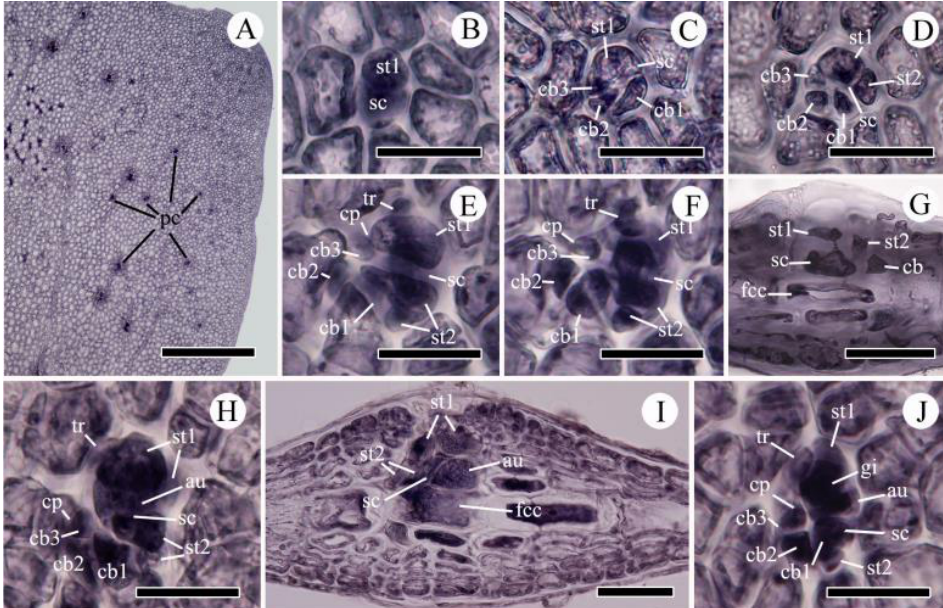
Figure 5. Female reproductive structures of Acrosorium flabellatum Yamada. ( A ) Positions of procarps (pc). ( B – G ) Procarp development. ( G ) Cross-sectioned mature procarp. ( H ) Surface view of early post-fertilization stage. ( I ) Cross-section view of early post-fertilization stage. ( J ) Surface view of young cystocarp before pericarp formation. au, auxiliary cell; cb, carpogonial branch (numbers, cell order); cp, carpogonium; fcc, fertile central cell; gi, gonimoblast initial; sc, supporting cell; st1, first sterile cell group; st2, second sterile cell group; tr, trichogyne. Scale bars: ( A ), 500 µm; ( C − I ), 50 µm; ( J ), 30 µ